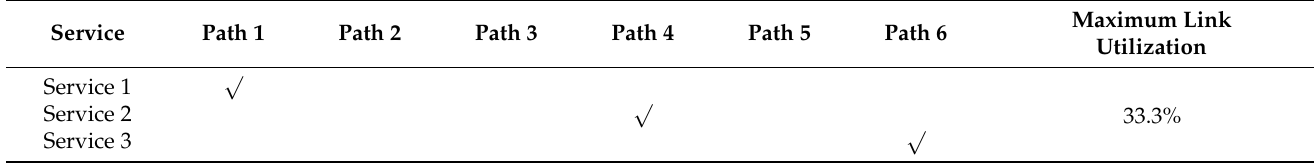
Table 4. Status of service deployment after optimization.